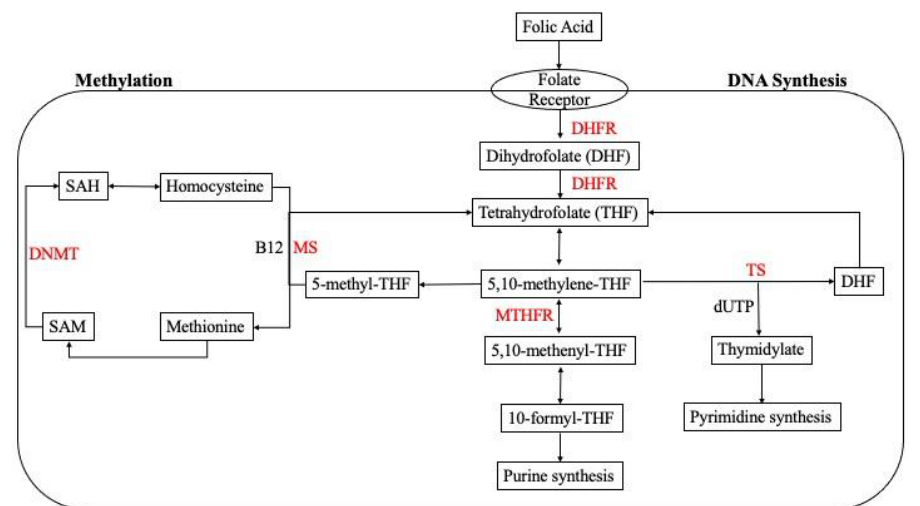
Figure 1. Cellular one-carbon (1C) metabolism. Folic acid undergoes a series of enzymatic reactions in the cell for purine and pyrimidine synthesis in the folate cycle. Homocysteine is metabolized through re-methylation in the methionine cycle. Abbreviations: 5,10-methylene-THF: 5,10-methylene-tetrahydrofolate; 5,10-methenyl-THF: 5,10-methenyl-tetrahydrofolate; 10-formyl-THF: 10-formyl-tetrahydrofolate, 5-methyl-THF: 5-methyl-tetrahydrofolate; SAM: S-adenosylmethionine; SAH: S-adenosylhomocysteine; DHFR: dihydrofolate reductase; MTHFR: methylenetetrahydrofolate reductase; TS: thymidylate synthase; MS: methionine synthase; DNMT: DNA methyltransferase.